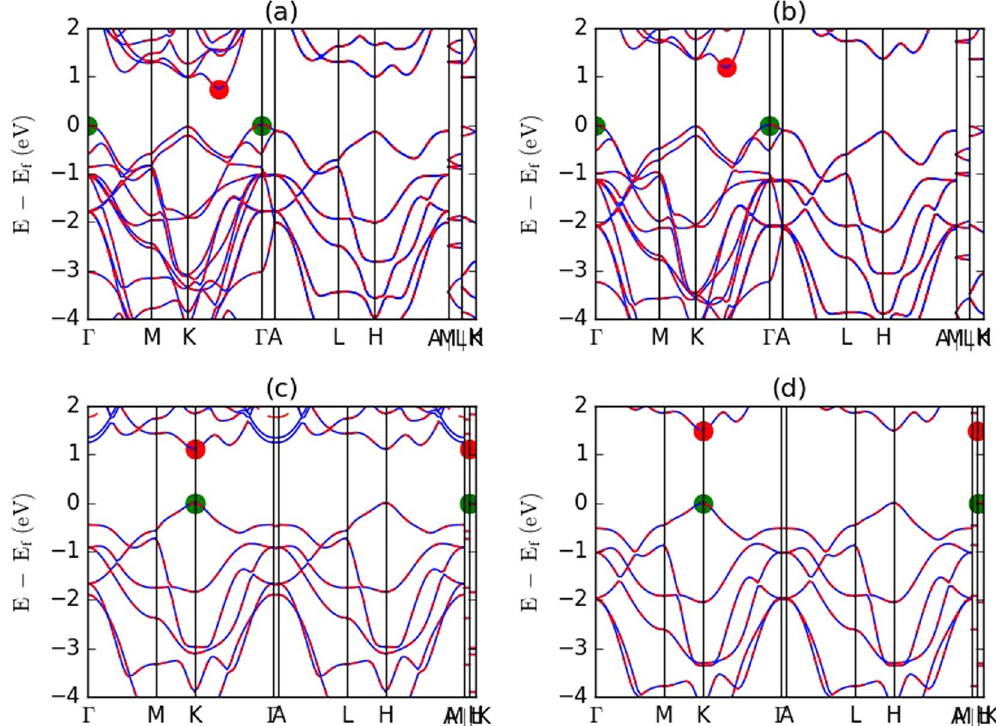
Figure 5. Bandstructures for MoTe 2 in bulk and layered phases. ( a ) Shows bandstructure for 2H MoTe 2 with optB88 and ( b ) with HSE06 functional. Similarly, ( c , d ) show bandstructure of single layer 2H MoTe 2 with optB88 and HSE06 functionals, respectively. Change of nature of bandgap from indirect to direct for bulk and single layer phases is validated.